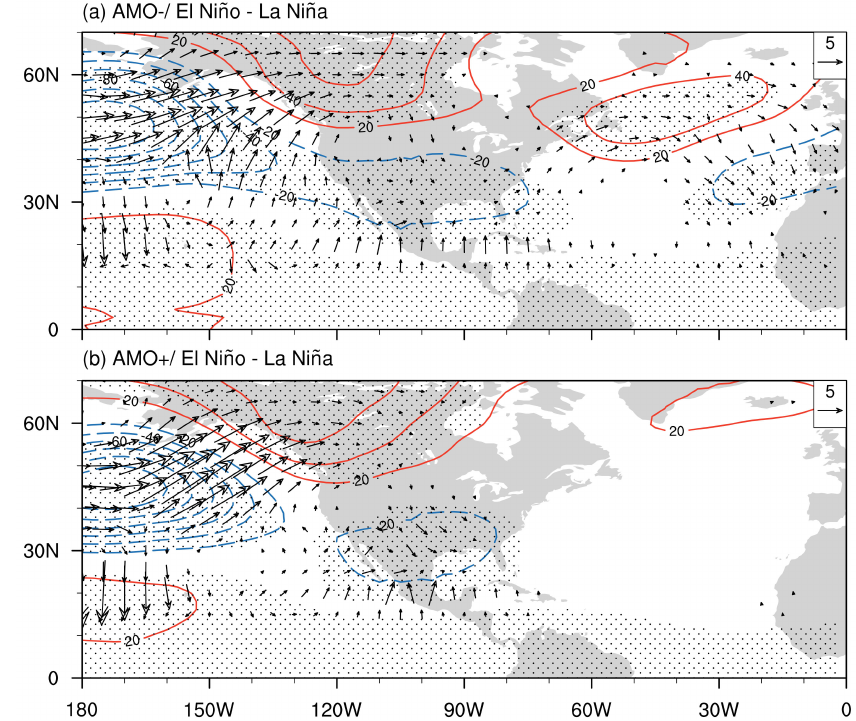
Figure 10. Same as Figure 9, except for differences of 500-hPa geopotential height (contour; units: gpm) in spring and the corresponding wave activity flux (vector; units: m 2 /s 2 ). The red solid and blue dashed contours represent positive and negative values, respectively. The contour interval is 20 gpm, and the zero isoline is omitted for clarity. Only the WAF with its amplitude exceeding 0.5 m 2 /s 2 is